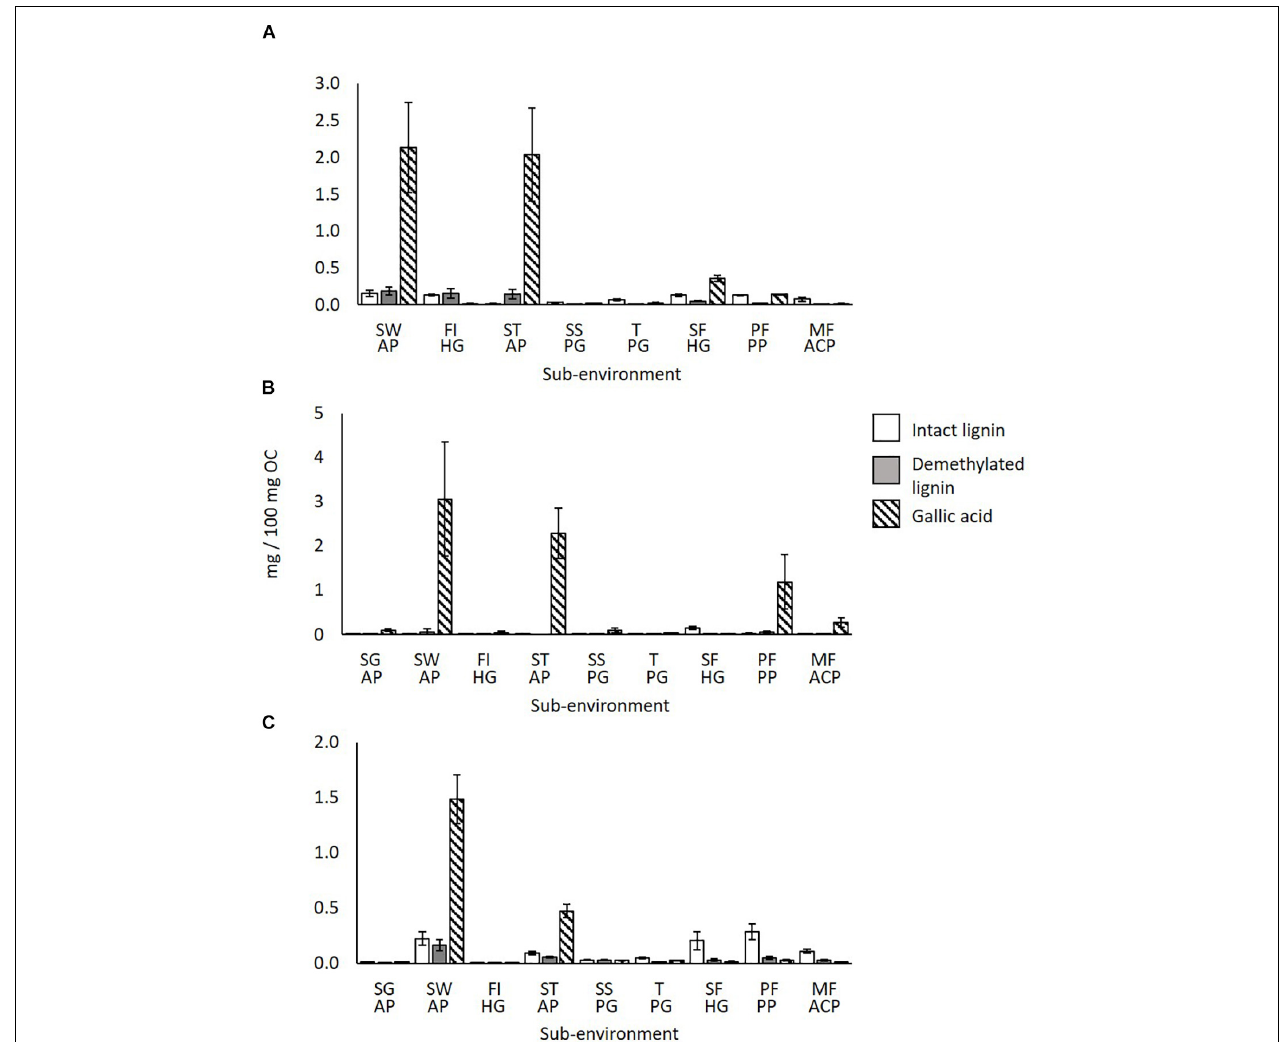
FIGURE 7 | Intact lignin, demethylated lignin and gallic acid amounts across the sampling transect (SG-MF) in (A) wood litter, (B) fresh shoot/leaf litter, and (C) surface soils. S.E. bars of 3 replicates shown. SG AP, Savannah Grassland Albic Plinthosol; SW AP, Savannah Woodland Albic Plinthosol; FI HG, Forest Island Humic Gleysol; ST AP, Savannah Tree Albic Plinthosol; SS PG, Savannah Swamp Plinthic Gleysol; T PG, Transition zone Plinthic Gleysol; SF HG, Swamp Forest Humic Gleysol; PF PP, Pisoplinthic Forest Pisoplinthic Plinthosol; MF ACP, Mixed Forest Acric